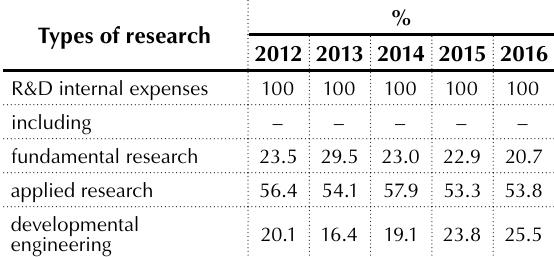
Table 5. R&D internal expenses by types of